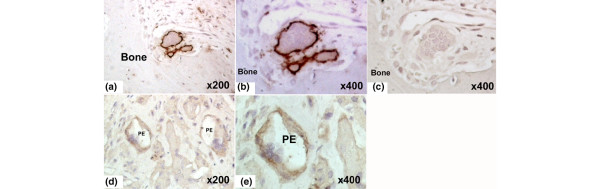
Detection of β3 integrin in sections of human peri-implant by immunohistochemistry using a rabbit polyclonal antibody. (a, b) β3 Integrin is evident in the membrane of mononuclear and multinuclear cells adjacent to bone. (d, e) Weak staining is evident in cells associated with polyethylene (PE) particles. Normal IgG was used as a negative control (panel c).